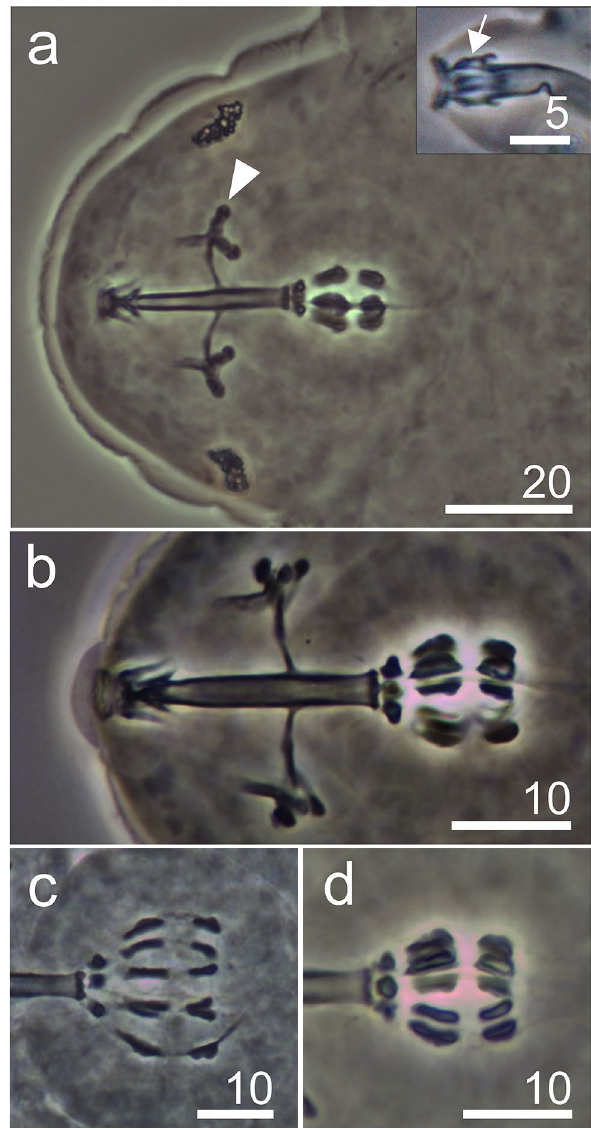
Figure 8. Hypsibius sp. from Mt. Gassan, bucco-pharyngeal structures (PCM): ( a ) cephalic part, buccal apparatus and eyes, arrowhead indicates typical Hypsibius type furcae, insert—AISM, ( b ) buccal apparatus, ( c,d ) macroplacoids and